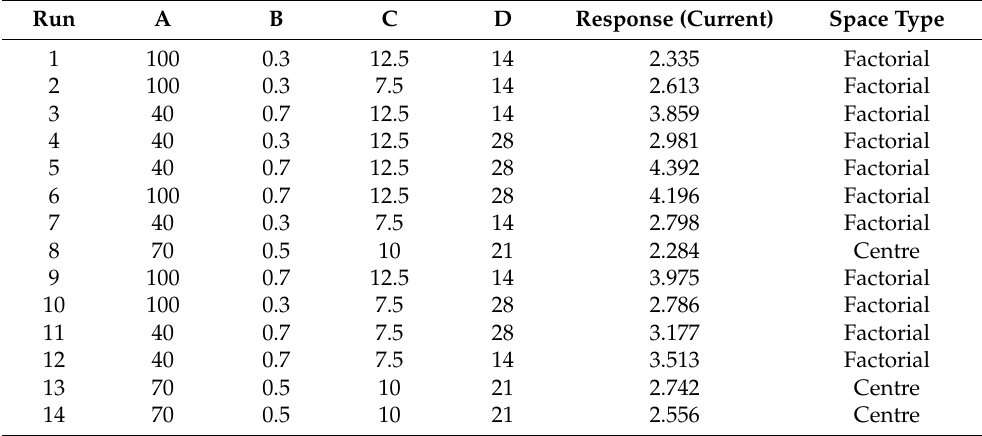
Table 2. Design matrix and the results of the central composite full factorial